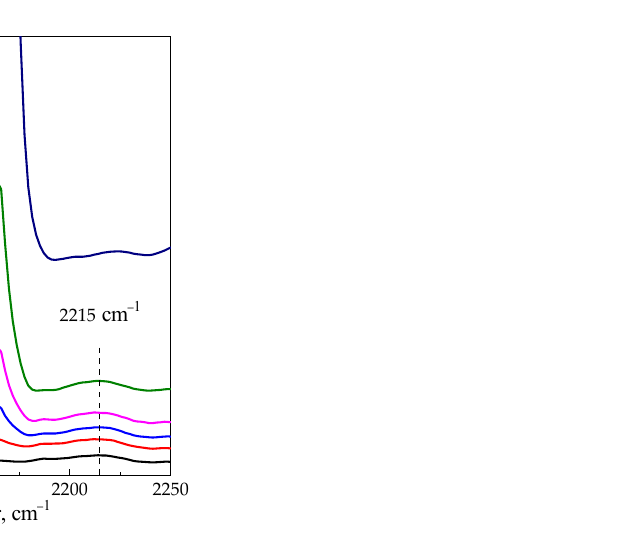
observed in the spectra: the band of weak intensity at ~2215 cm − 1 corresponds to CO com- plexes with LASs, and the main band with a maximum at 2165–2163 cm − 1 is related to CO complexes with BASs [24,84,96–98]. The intensity of the first band increases with CO pres- sure up to 2.5 torr; the second band reaches a maximum intensity under 10 torr. The con- centrations of acid sites measured from the intensity of the corresponding bands are 7 and 140 µmol/g for LASs and BASs, respectively. These values are close to those measured from the spectra of adsorbed pyridine (10 and 135 µmol/g).